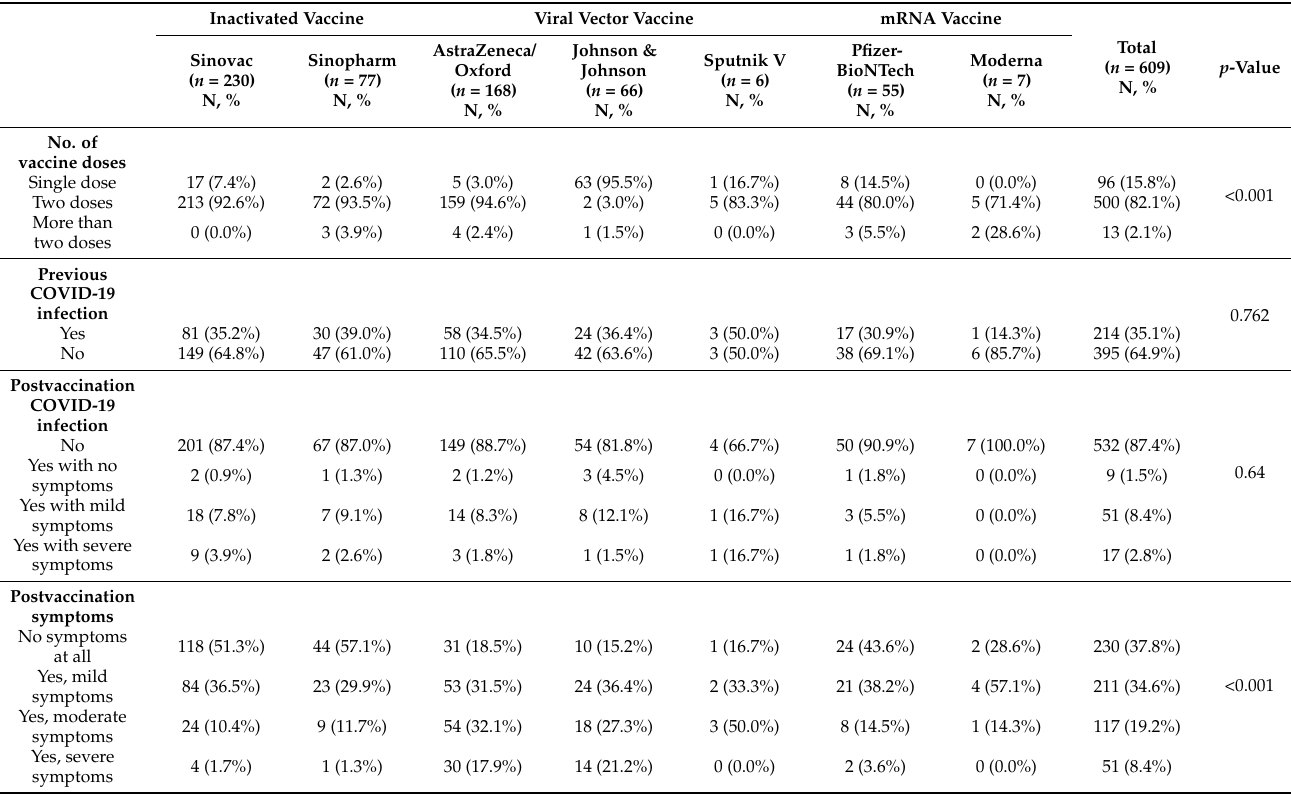
Table 2. COVID-19-related anamneses of the participants according to type of vaccine ( n =